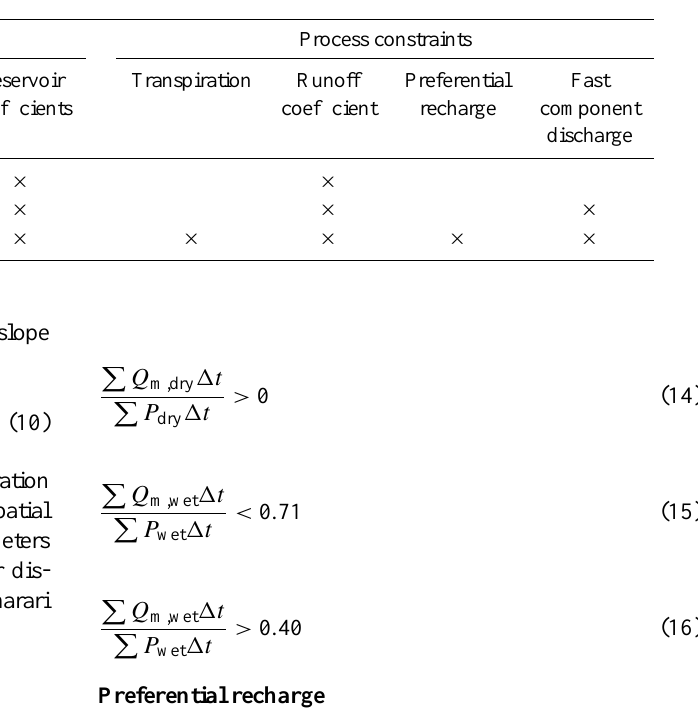
Table 3. The applicability of different parameter and process constraints for the three different model structures, FLEX A , FLEX B and FLEX C .